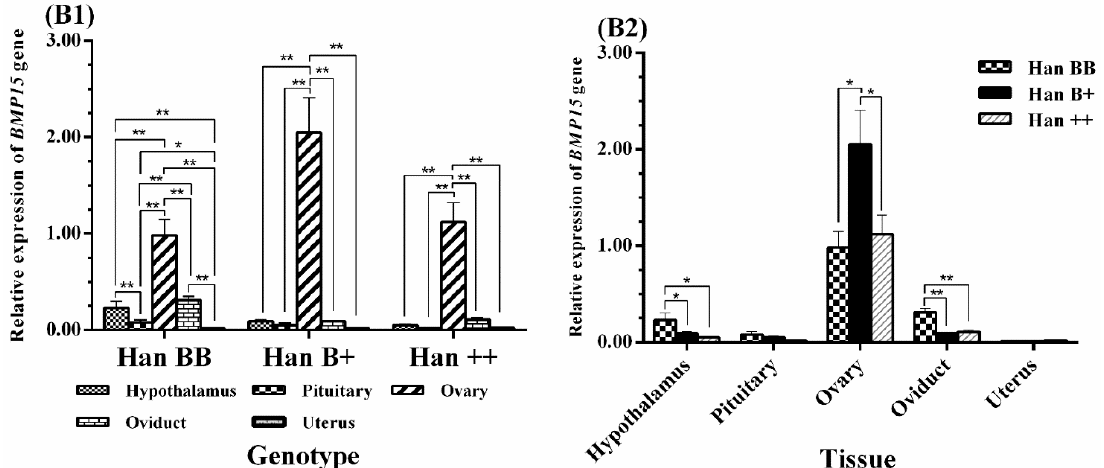
Figure 4. Comparison of expression of BMP15 among three FecB genotypes ( B1 ) and among tissues ( B2 ). Means with different superscripts are significantly different. The significant results with a p -value lower than 0.01, 0.05 are giving two asterisks (**) and one asterisk (*), respectively. Nonsignificant results are not giving any asterisks.